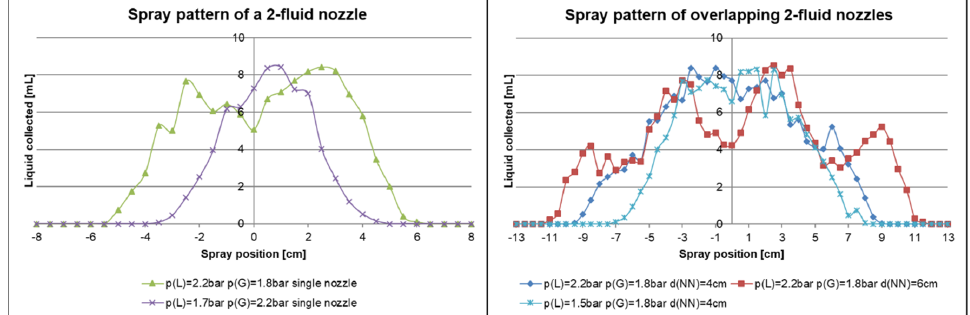
Figure 14. Spray pattern of a 2-fluid nozzle using different liquid pressure, p(L) , and gas pressure, p(G) , ( left ); Spray pattern of two 2-fluid nozzles overlapped using different pressures and distances of the nozzles, d(NN) , ( right ). The spraying pattern along the y-axis was measured with a spray collector. Water was used as the liquid and the nozzle to support distance was d(NS) = 15 cm.